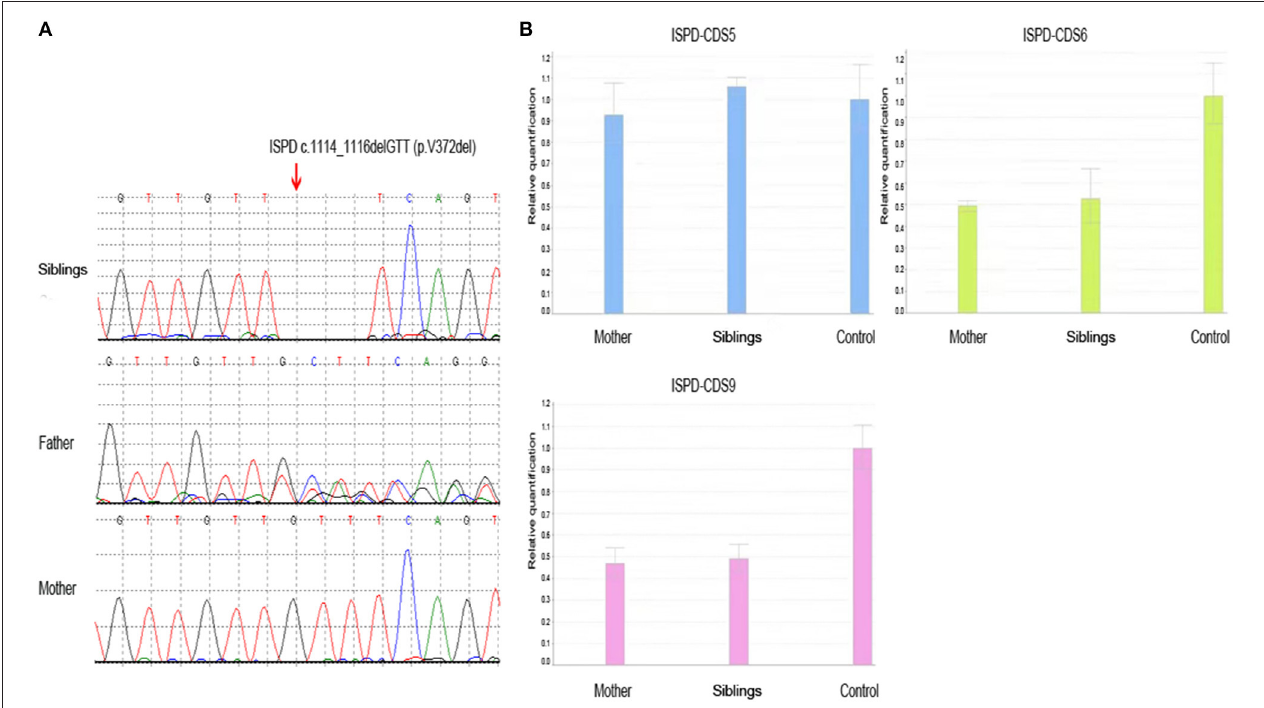
FIGURE 2 | The result of whole-exome sequencing of the siblings. (A) The siblings had ISPD c.1114_1116delGTT (p.V372del) mutation, which was inherited from the father, while the mother did not carry the mutation. (B) The siblings had ISPD exon 6–9 deletion, which was inherited from the